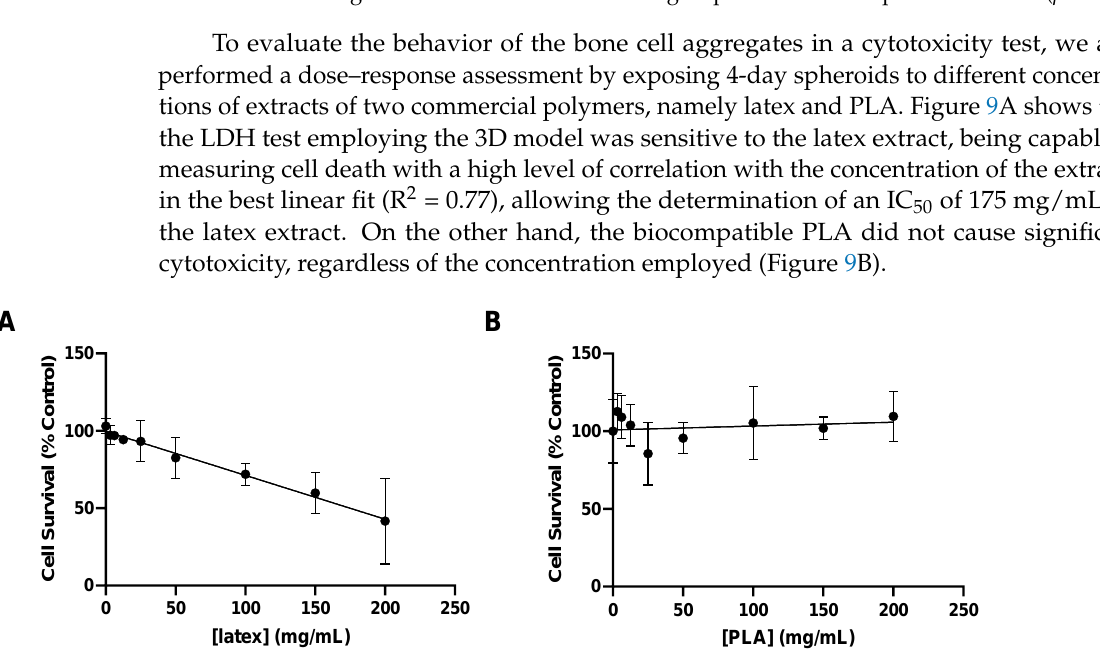
Figure 9. LDH test of aggregates at 4 days after seeding (30,000 cells), submitted to extracts of different proportions of commercial latex ( A ) or polylactic acid (PLA) ( B ). Results represent mean ± SD survival, as a % of the control (unexposed cells) of two independent experiments in quintupli- cates.